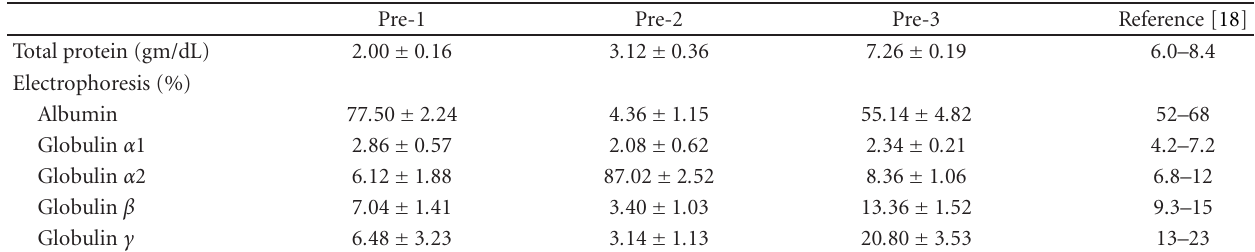
Table 1: Serum protein components separated by di ff erent elution bu ff